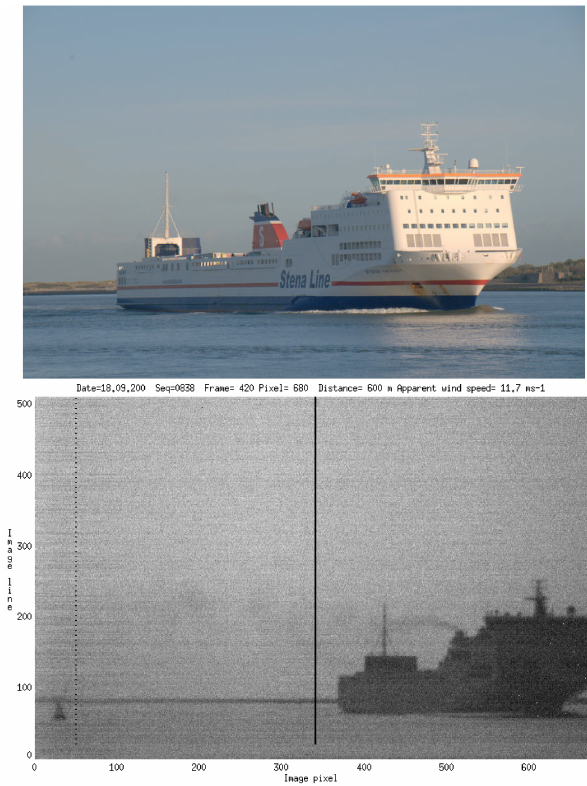
Fig. 14. Stena Hollandica under steam. Top: Visible photograph. Bottom: UV image of the same ship. The black line shows the lo- cation of the vertical transect through the plume; the dashed line shows the location of the reference vertical profile.